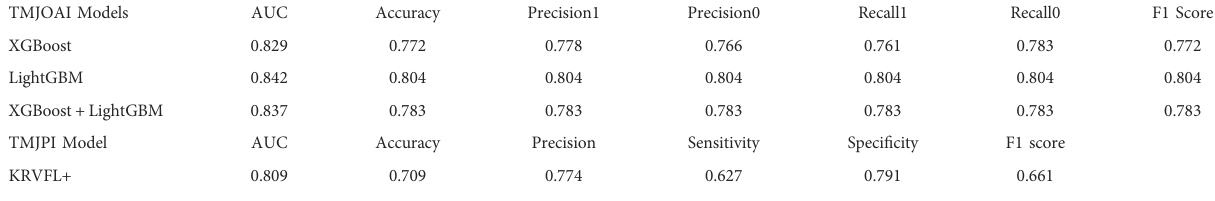
TABLE 2 Comparison metrics for the fi nal model in TMJOAI and TMJPI. Multi-class precision and recall for the TMJOAI models are shown as Precision1 and Recall1 for OA and Precision0 and Recall0 for control groups, respectively, and the fi nal F1-score was calculated by taking the macro average of the two classes ’ F-1 scores (38, 39).